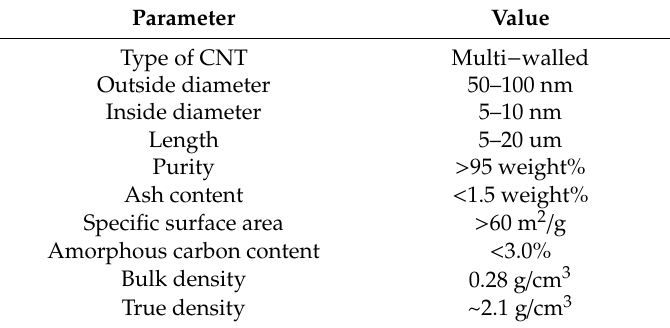
Table 2. Properties of the Carbon Nanotubes Used in this Study *.